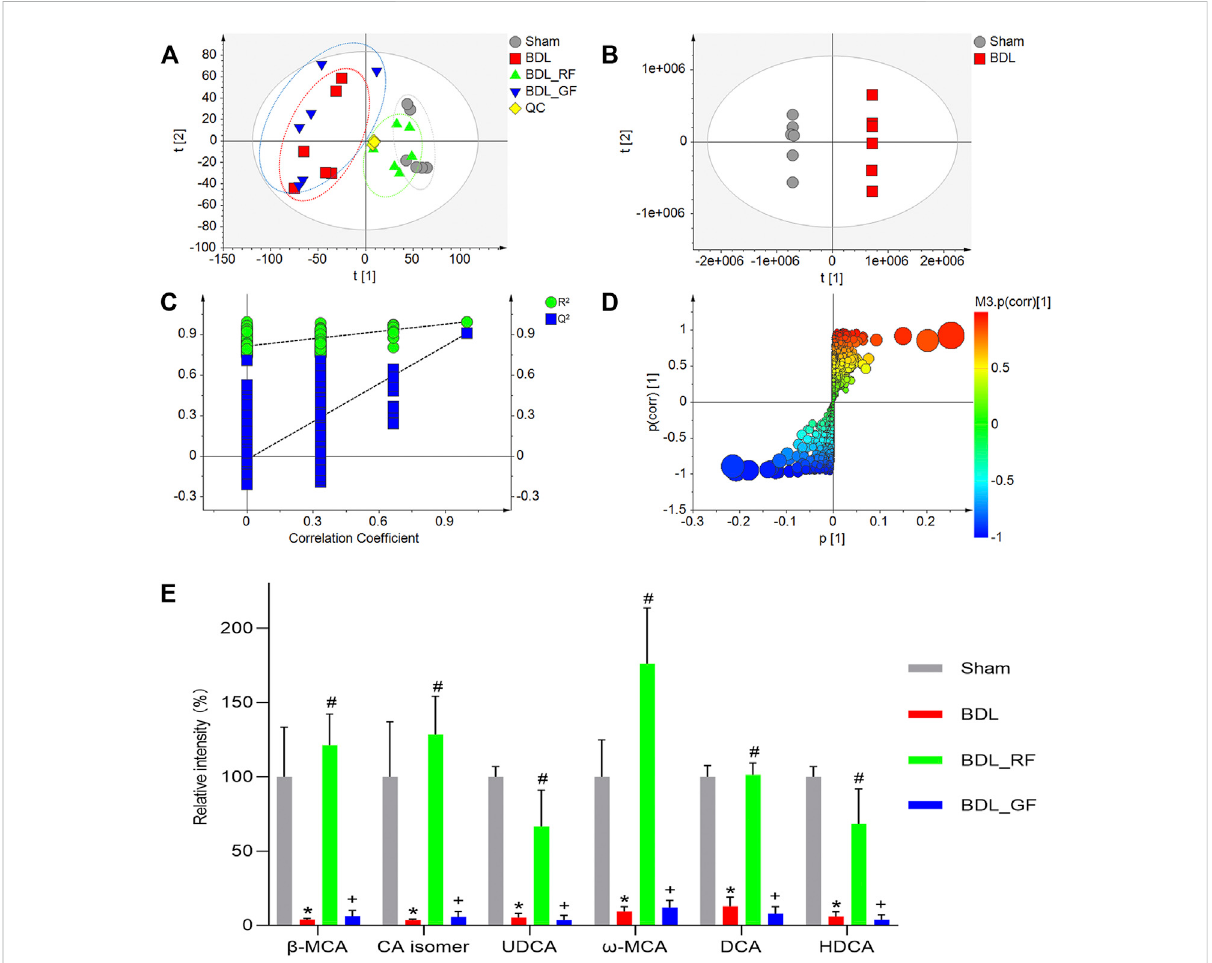
FIGURE 5 EffectsofRFandGFonentericmetabolismofBDL-rats. (A) Principalcomponentanalysis(PCA)scoreplotoffourgroups. (B) Orthogonalpartial least squares discriminant analysis (OPLS-DA) score plot of the Sham and BDL groups. (C) Cross-validation of the constructed model. (D) OPLS-DA S-plot of the Sham and BDL groups. The size of each point was shown according to its value of Variable importance on projection (VIP). (E)